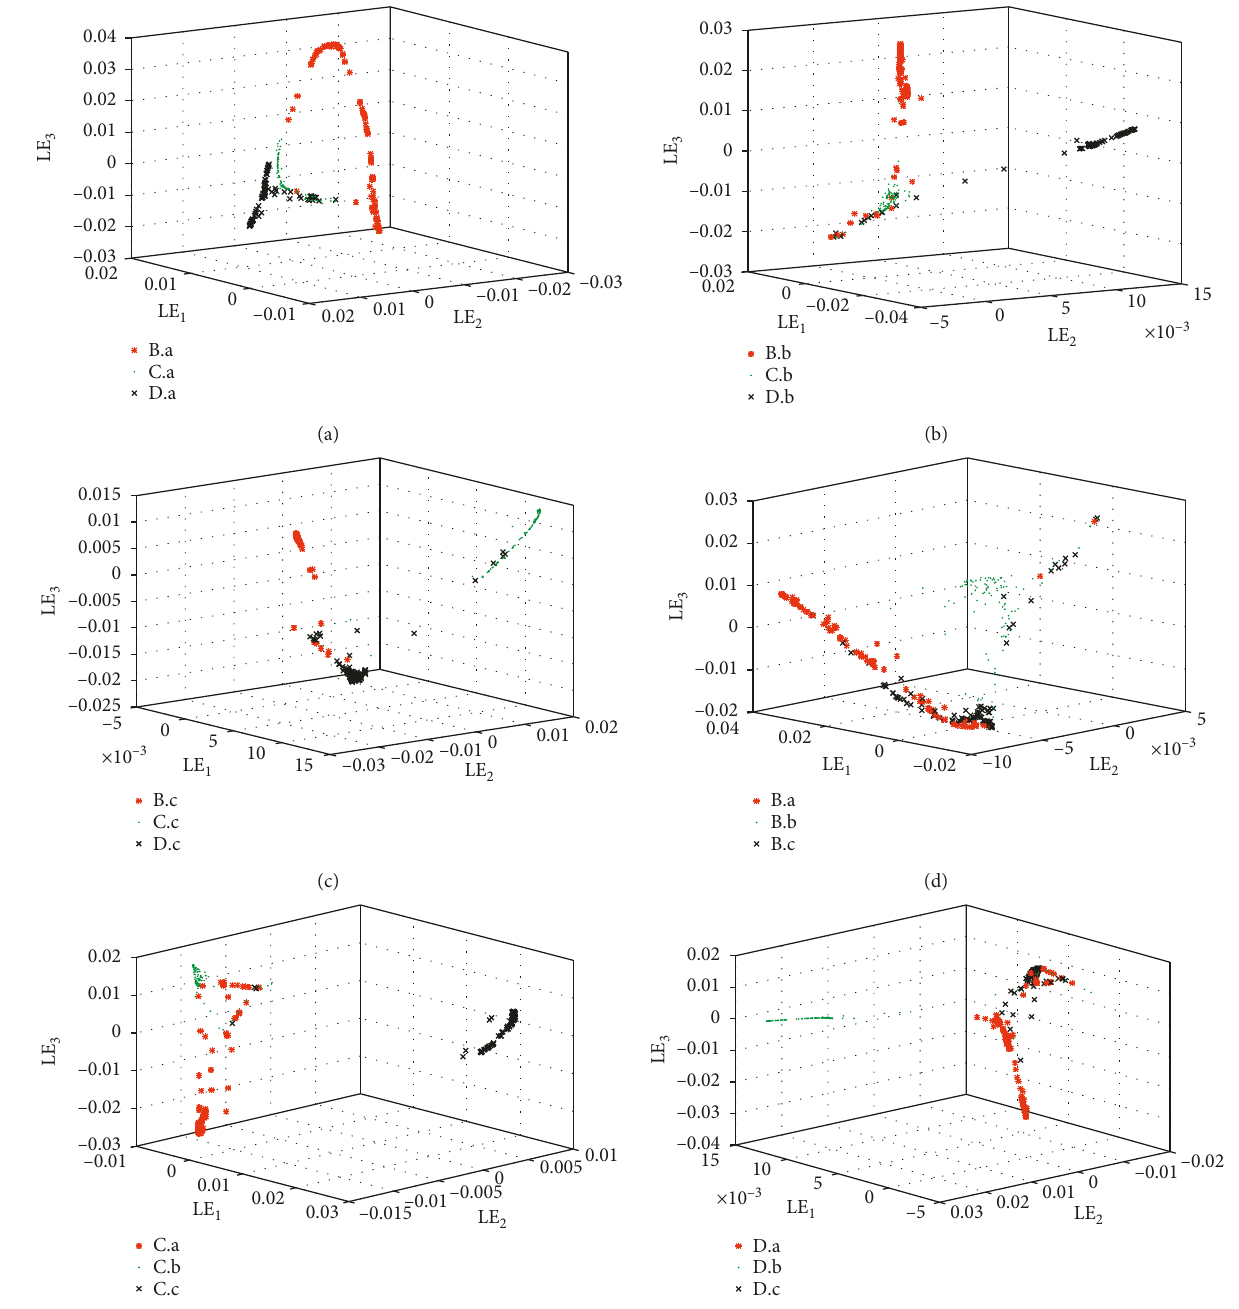
Figure 5: 3D scattered plots from 23-dimensional features in reference [30]. (a) Fault set 1. (b) Fault set 2. (c) Fault set 3. (d) Fault set 4. (e) Fault set 5. (f) Fault set